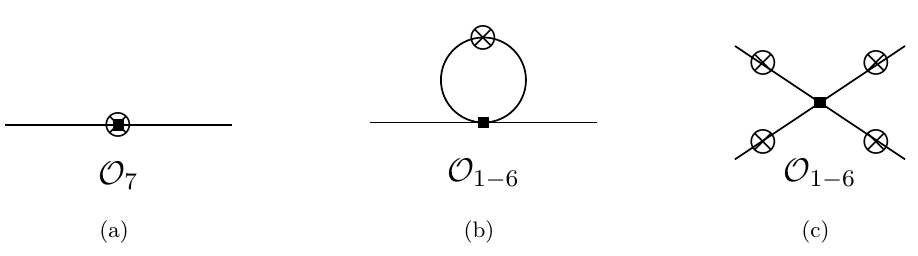
Figure 1 . Leading contribution to h π‘ + ‘ − |H ( q ) circled cross marks the possible insertion of a virtual